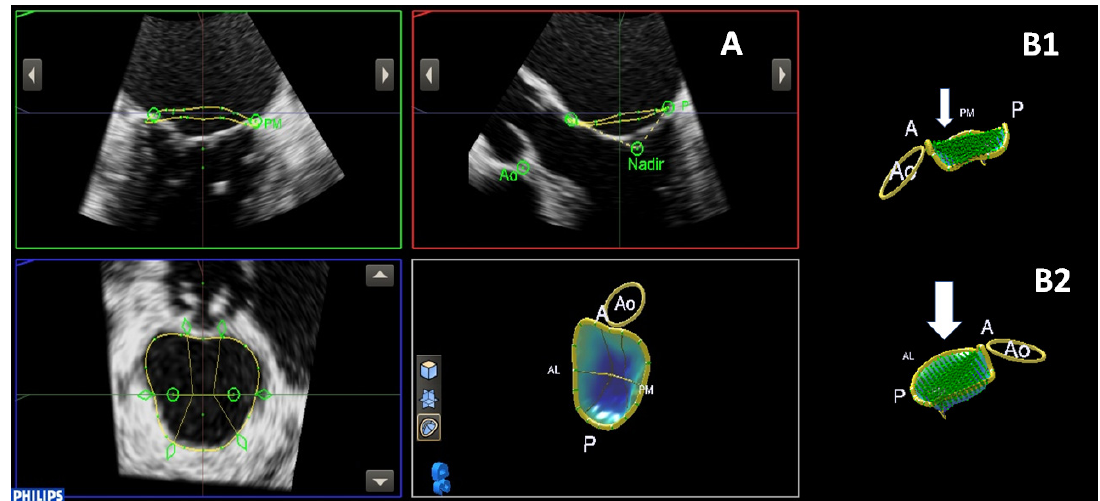
Figure 1. ( A ) Mitral valve quantification analysis: an example of MVQ analysis showing bi- commissural view ( upper-left box ), left ventricular outflow tract view ( upper-right box ), MV annulus in short axis ( lower-left box ) and 3D reconstruction of the MV annulus and leaflets ( lower-right box ). ( B1 ) Three-dimensional (3D) reconstruction of the MV annulus and leaflets in D-MR patients, where the green area represents the tenting volume; ( B2 ). Three-dimensional (3D) reconstruction of the MV annulus and leaflets in P-MR patients, where the green area represents the tenting volume, which is higher if compared with D-MR and labeled by a big white arrow. Moreover, D-MR presented with higher LVEF (32 ± 7 vs. 26 ± 5%, p = 0.003), while LVEDV/i, LVESV/i and LV mass were higher in P-MR (LVEDV/i 80 ± 20 vs. 126 ± 27 mL, p = 0.001; LVESV/i 60 ± 20 vs. 94 ± 23 mL, p < 0.001; LV mass 249 ± 63 vs. 301 ± 69 gr, p = 0.035, respectively). Examples of 3D LV analysis in D-MR and P-MR are shown in Figure 2A,B and Supplementary Videos S2a,b. EROA was slightly higher in D-MR, although this difference was non-significant (0.39 ± 0.1 vs. 0.33 ± 0.1, p = 0.7). GLS was slightly higher in P-MR compared to D-MR, despite both being severely impaired ( − 9.5 ± 4.1% vs. − 7.2 ± 2.7%, p = 0.048). In Supplementary Video S3, an example of GLS analysis is depicted. Figure 3 shows differences in LVEDV, LVESV, tenting height and tenting volume in D- MR and P-MR.